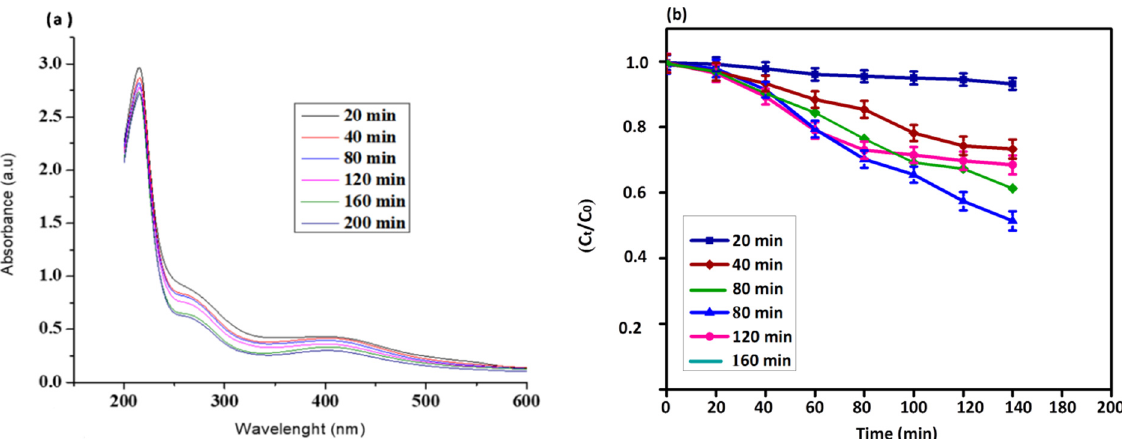
3 O 4 nanoparticles.